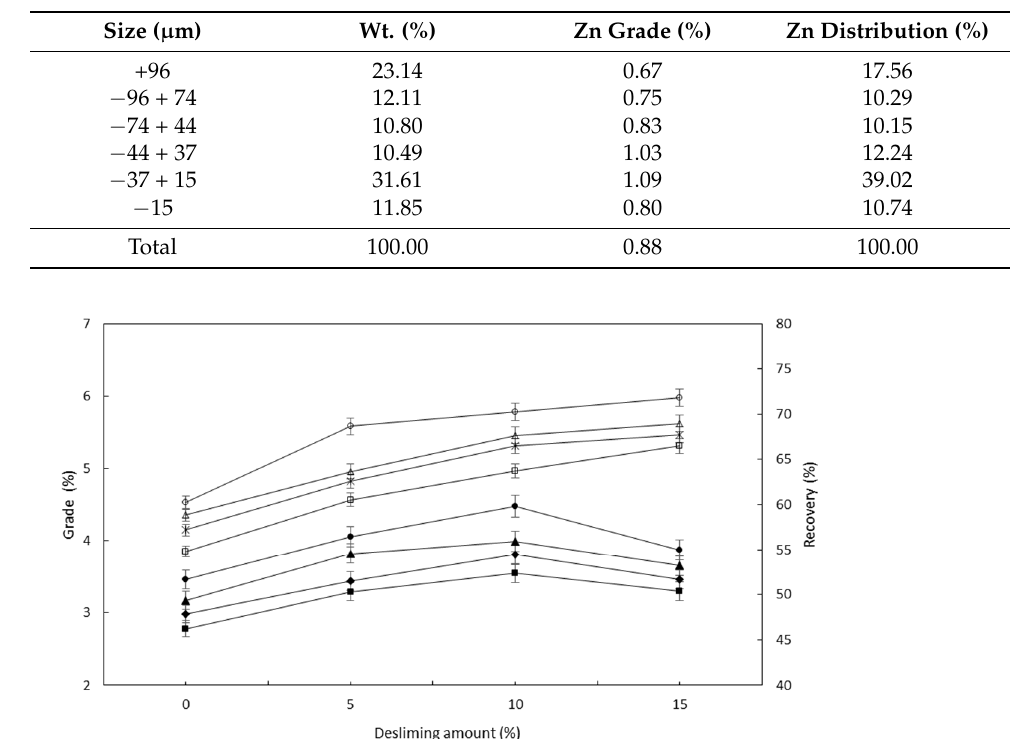
Table 2. Zinc grade and distribution of feed sample.